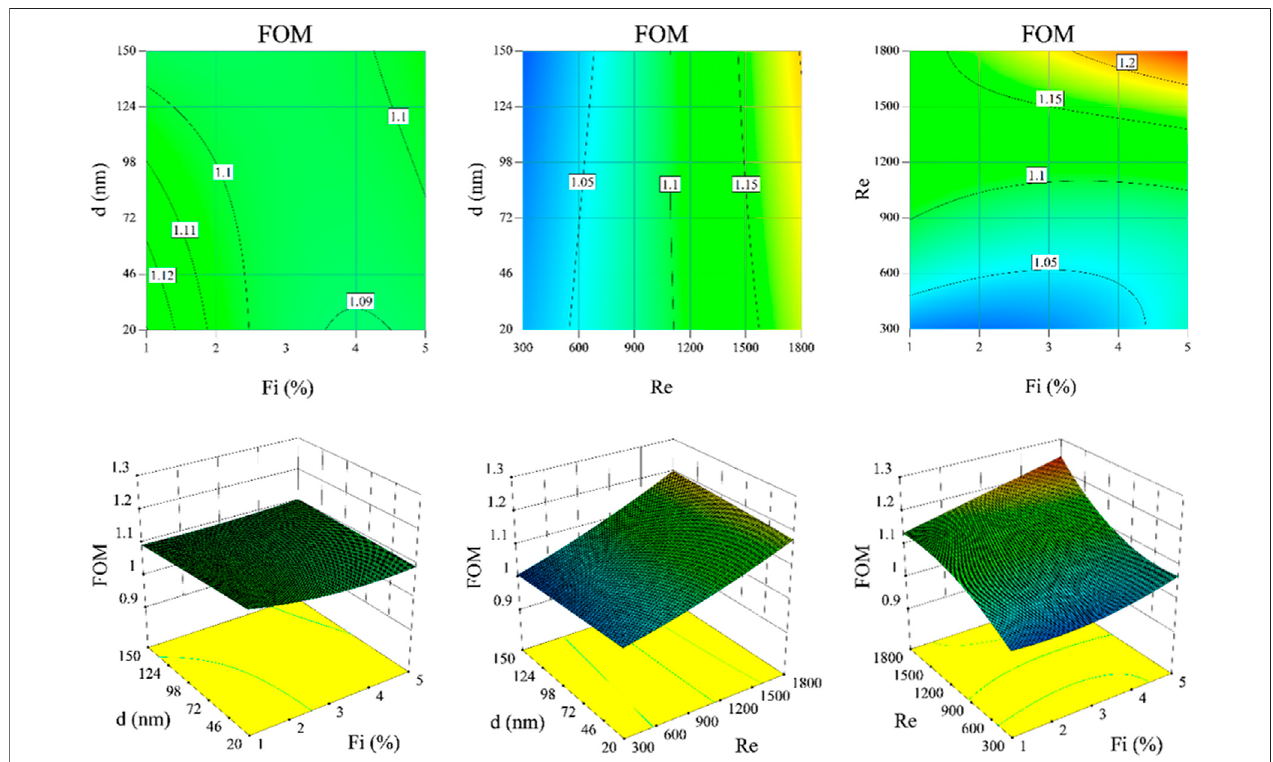
FIGURE 9 | FOM for dissimilar values of Re , d , and Fi